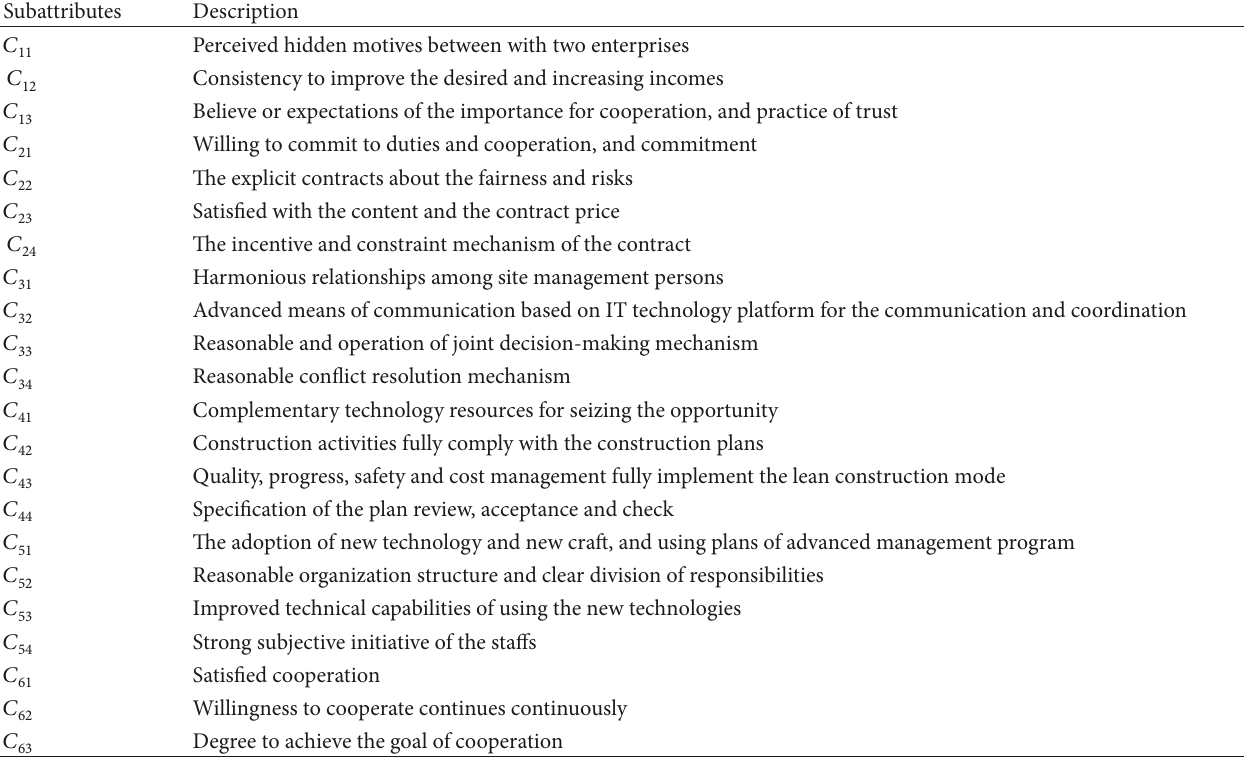
Table 2: A basic decomposition of collaboration subattribute (Source from: [10–12,